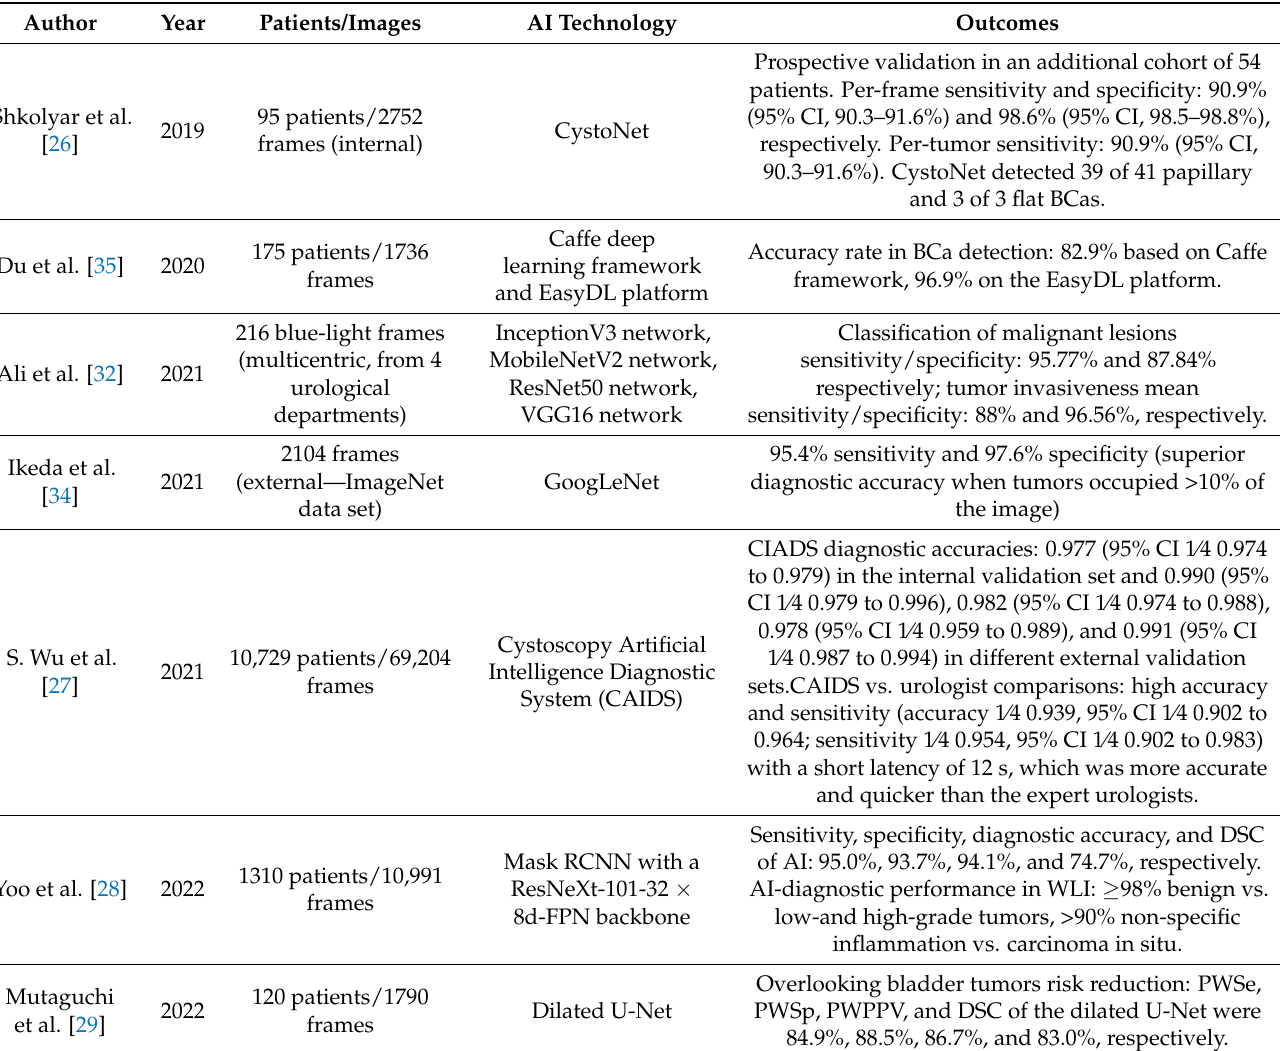
Table 1. Deep Learning approach applied to cystoscopy